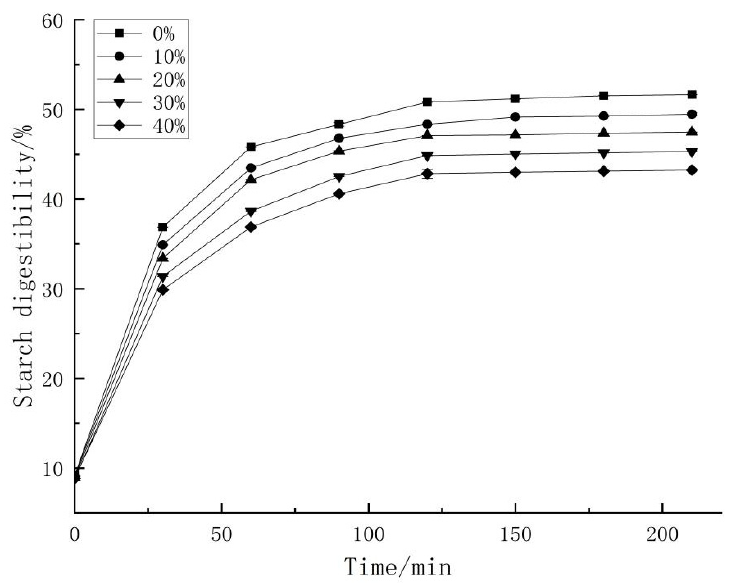
Figure 3. Starch digestibility of ginkgo biloba noodles. Table 9. In vitro starch digestion kinetics and glycemic index determination of GBN.